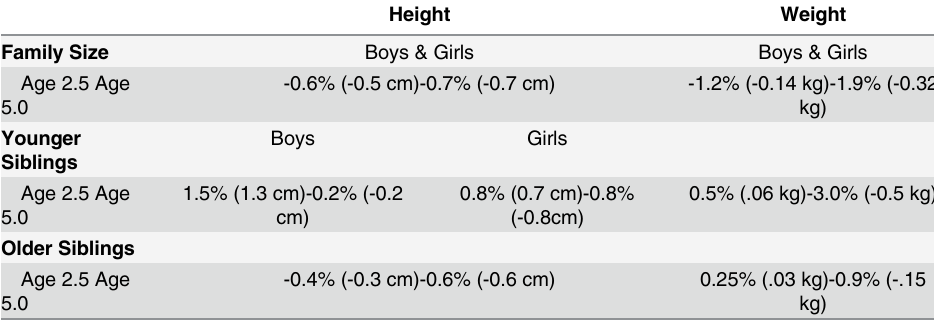
Table 2. Percent and absolute change in height (cm) and weight (kg) with each addition in family com- position. Values taken from best-fit model results in S2a and S2b Table. Boys and girls are reported sepa- rately for younger siblings and height because the interaction with gender is significant in this case (S1